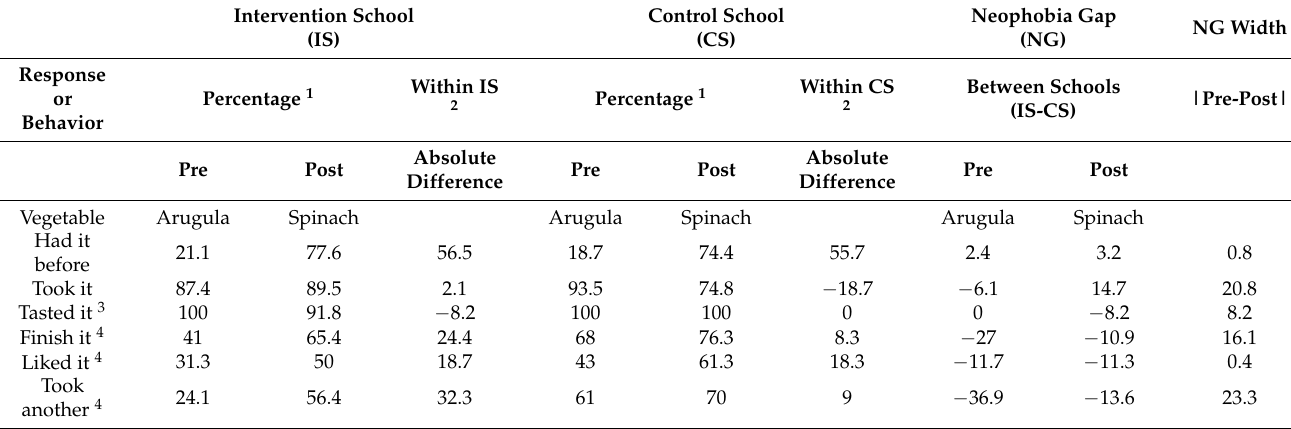
Table 2. Comparison of oral survey and behavioral observations pre/post percentages in each school and absolute differences between the intervention school ( n = 95) and the control school ( n =